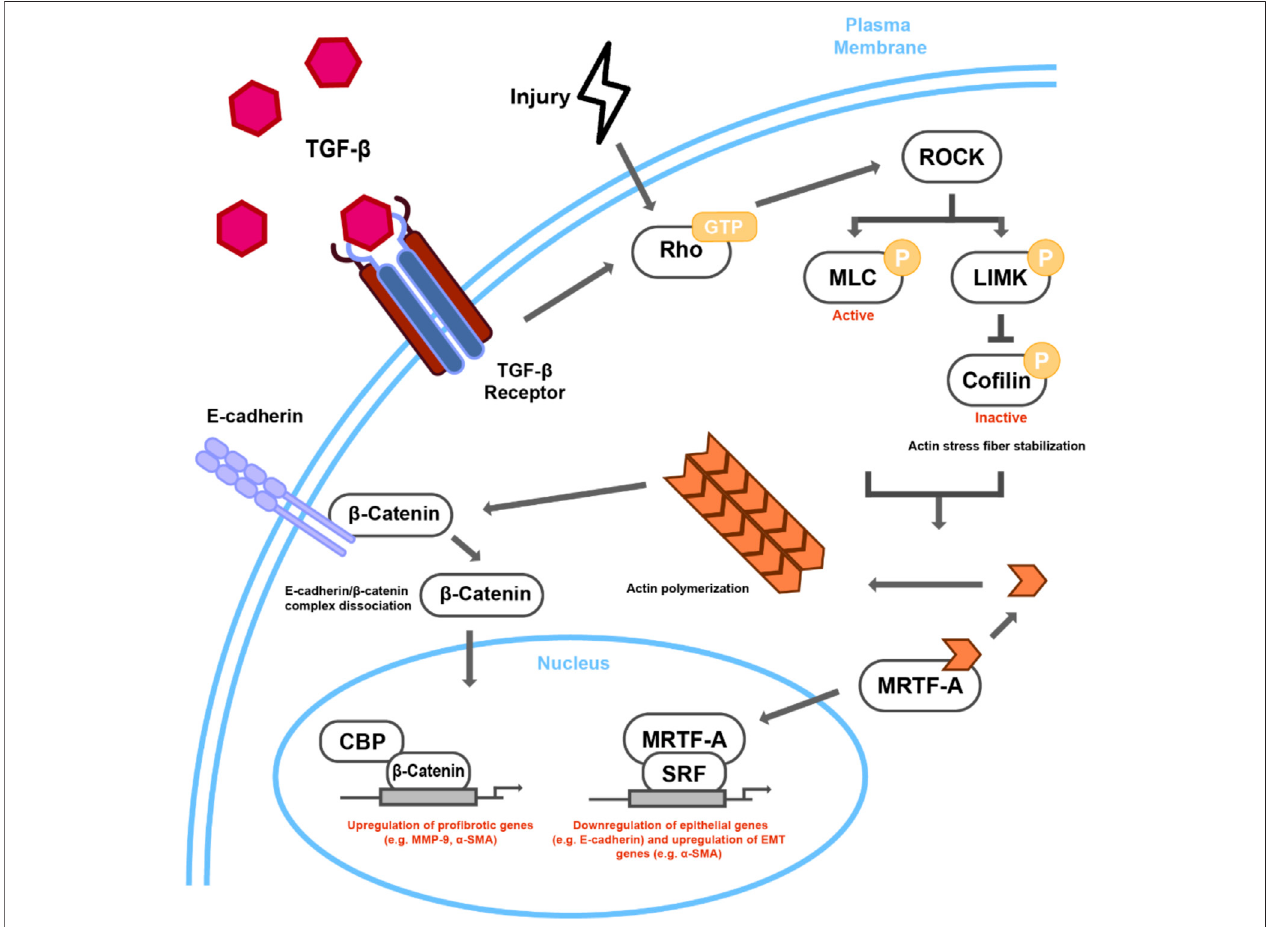
FIGURE 2 | Proposed mechanism of Rho-dependent cytoskeletal signaling in TGF β /Injury-induced lens EMT. TGF β stimulation or injury leads to Rho-GTP regulated ROCK activation. ROCK leads to actin stress fi ber formation and actomyosin contractility through phosphorylation of both MLC and LIMK, the latter of which phosphorylatesco fi lin,renderingitinactive.IncorporationofG-actinmonomersintocontractilestress fi bersleadstothenuclearaccumulationofMRTF-A,whichwhenin complex with SRF, can activate the transcription of EMT-related targets, such as α SMA. The interaction of stress fi bers with E-cadherin can then destabilize E-cadherin/ β -catenin complex leading to nuclear transcriptional activity of β -catenin, speci fi cally through CBP and other unknown transcription factors.